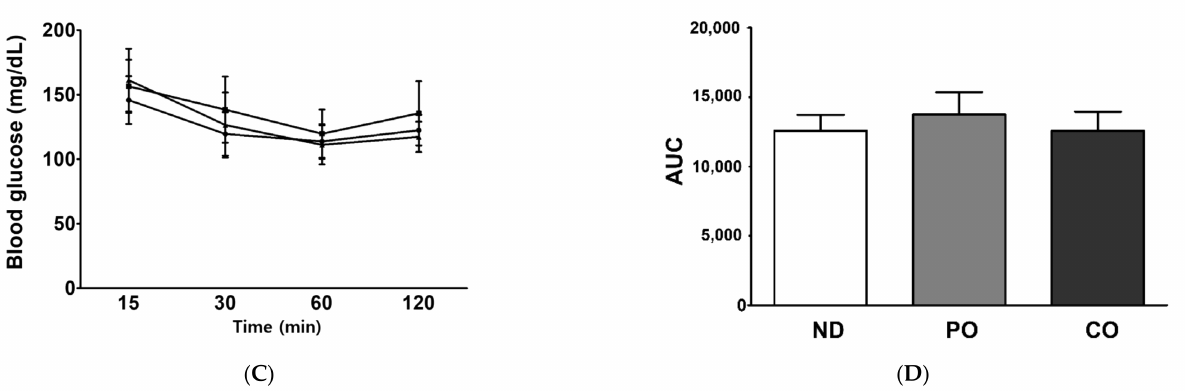
Figure 2. Partial replacement of dietary fat with PO or CO on the fasting glucose and insulin levels in ob / ob mice. Mice were fed either an ND or an ND partially replaced with PO or CO for 12 weeks ( n = 16 per group). Mice were injected glucose by oral gavage and blood glucose levels were measured at 0, 15, 30, 60 and 120 min after glucose injection; oral glucose tolerance test (OGTT) (1 g/kg body weight). Insulin tolerance test (ITT) was performed after feeding the experimental diet and blood glucose levels were measured at 15, 30, 60, 120 min after insulin administration (1 U/kg body weight). ( A ) OGTT at 11 weeks; ( B ) area under the curve (AUC) of OGTT; ( C ) ITT at 11 weeks; ( D ) AUC of ITT. Values are presented as the mean ± standard deviation. Data were analyzed using one-way ANOVA followed by Tukey’s post hoc test.